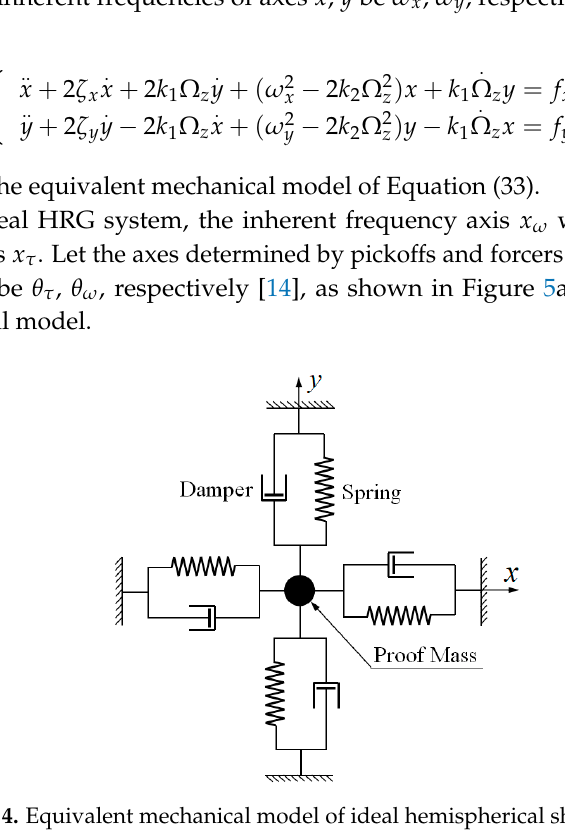
Figure 4. Equivalent mechanical model of ideal hemispherical shell resonator.